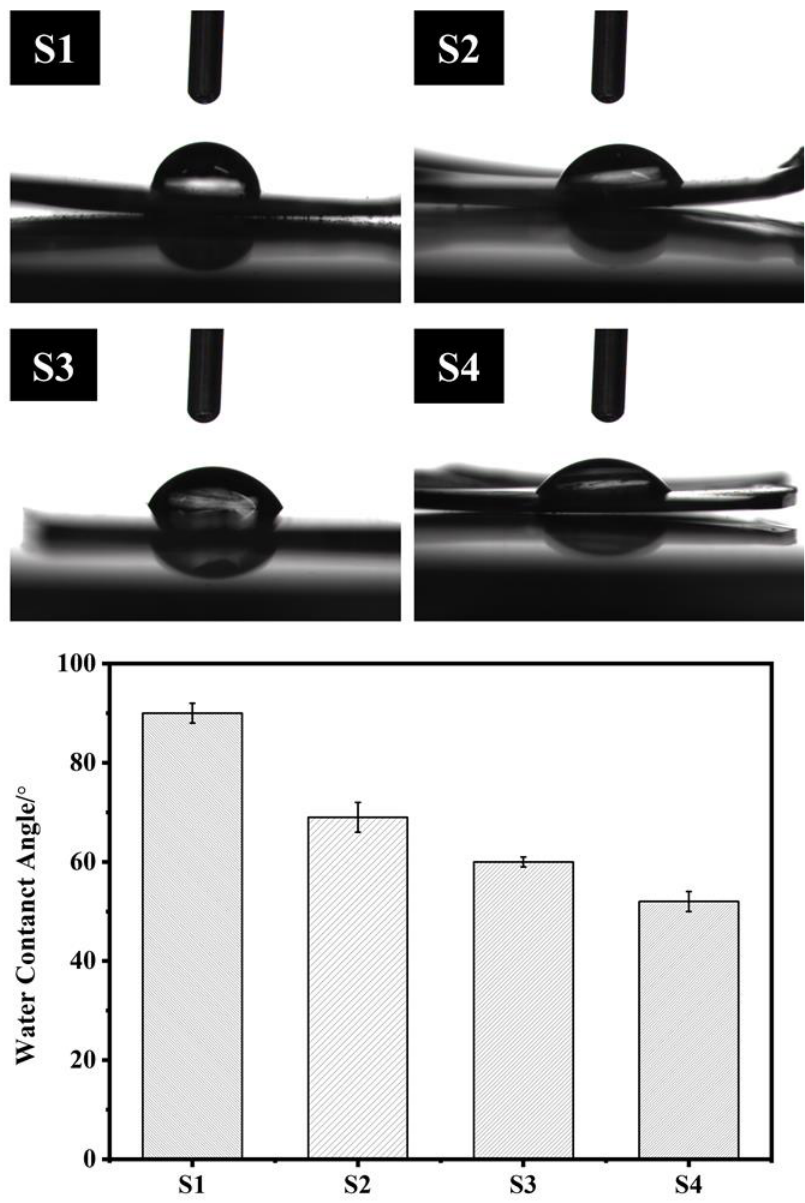
Figure 7. The water contact angle of the S1 – S4.